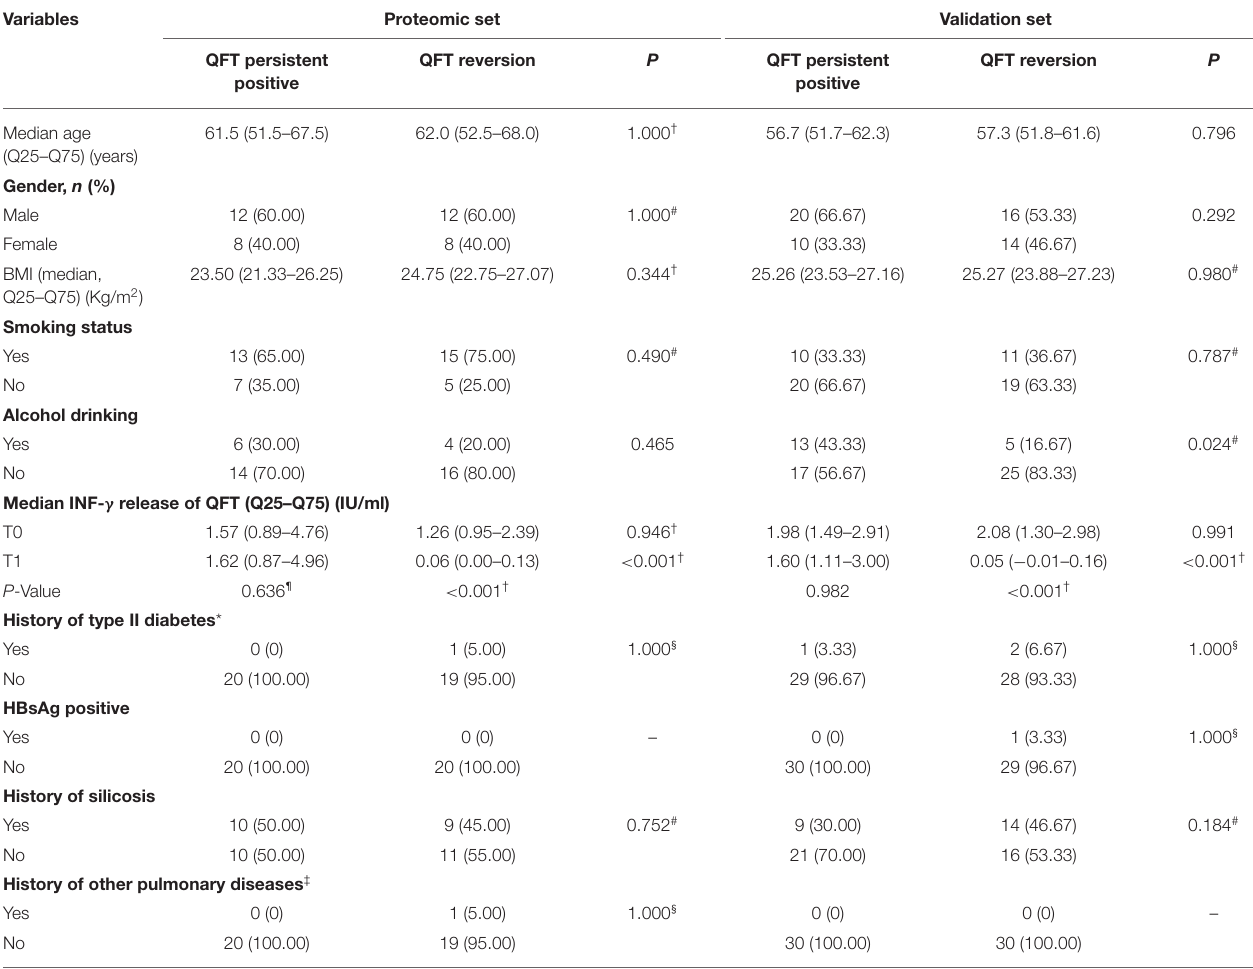
TABLE 1 | Characteristics of the participants included in the study.